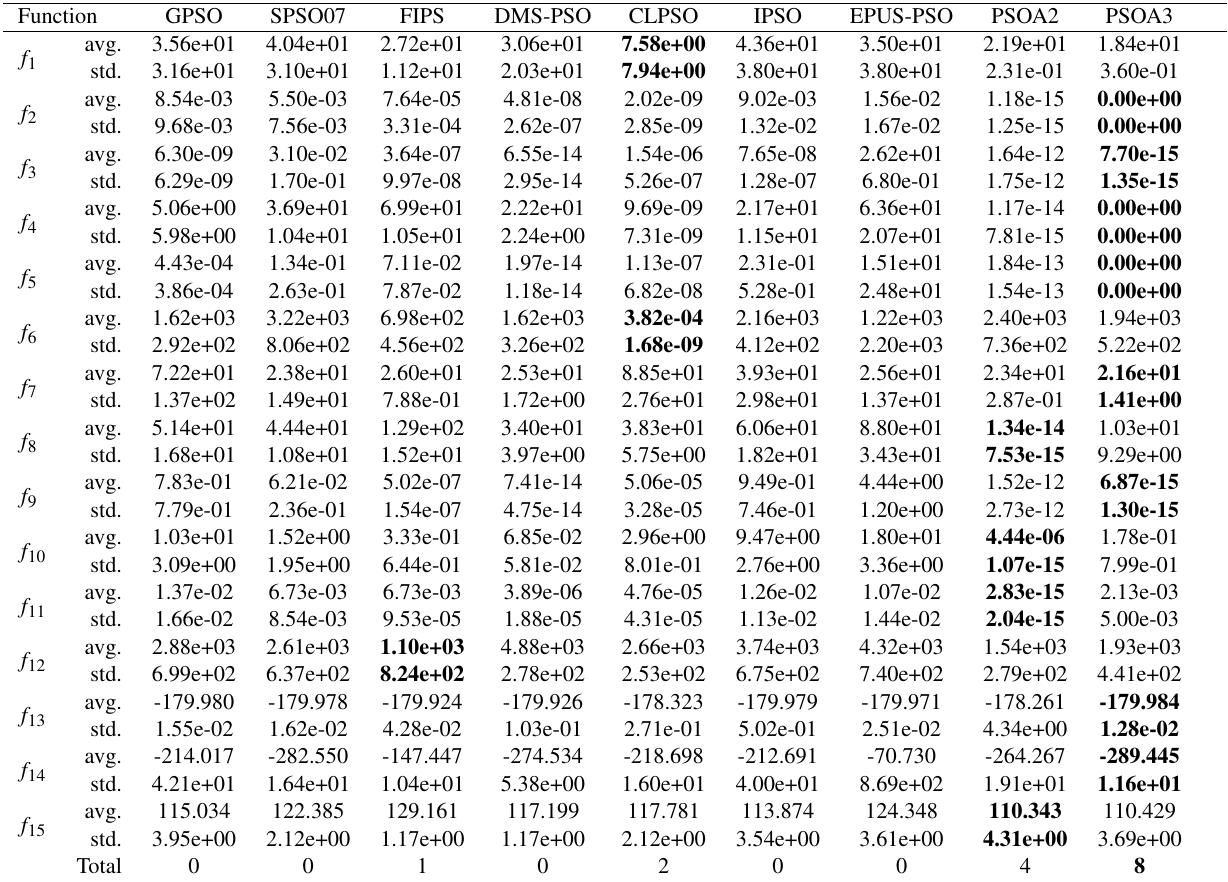
Table 7: Results with PSOA and the compared eight PSOs on the 15 functions with 30-D Function GPSO SPSO07 FIPS DMS-PSO CLPSO